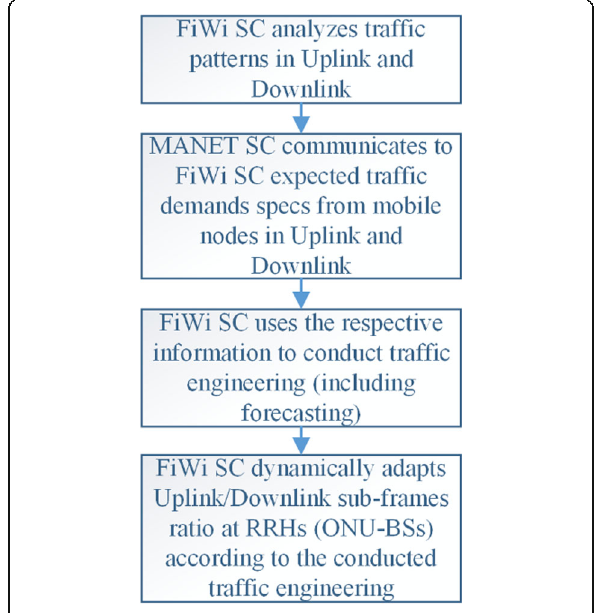
Fig. 11 Federated tasks performed by FiWi and MANET SDN controllers (SCs) to conduct Traffic